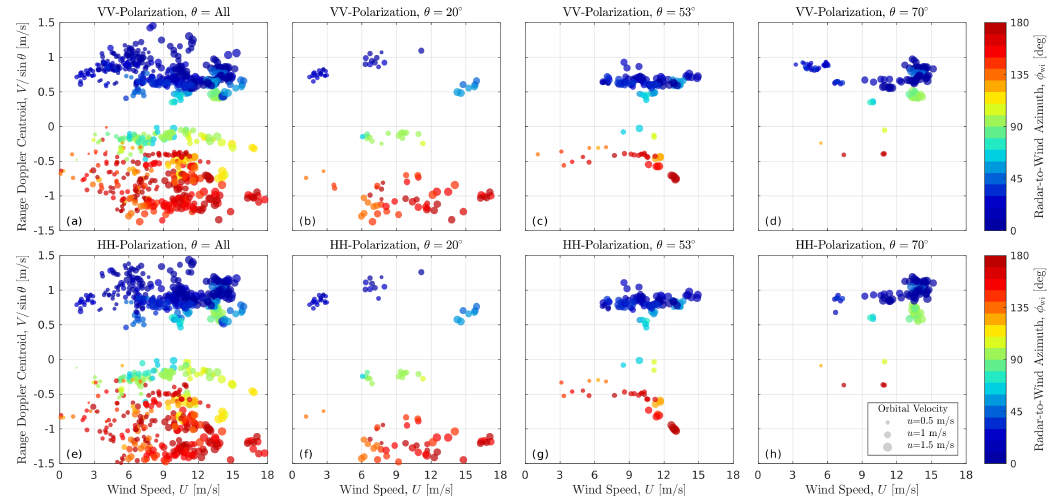
Figure 6. Doppler centroids versus wind speed for ( a , e ) all incidence angles, ( b , f ) θ = 20 ◦ , ( c , g ) θ = 53 ◦ , and ( d , h ) θ = 70 ◦ . ( top row ) VV-polarization, ( bottom row ) HH-polarization. Symbol size corresponds to the characteristic wave orbital velocity magnitude, u = ω p H s . Only co-aligned winds and waves, | φ − φ wa | < 25 ◦ , are wi